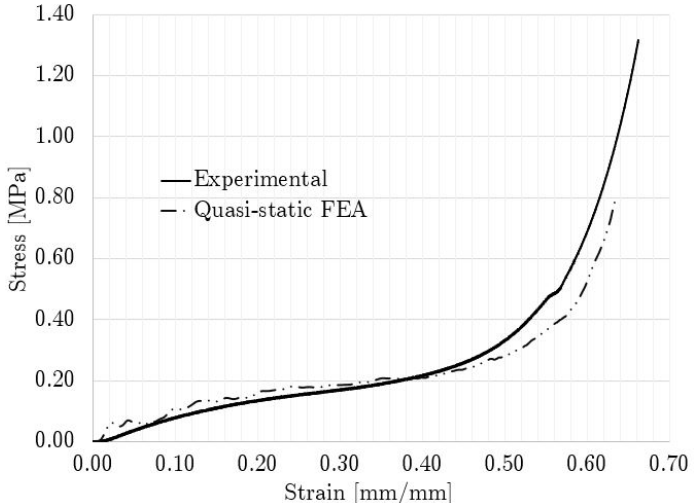
Figure 7. Quasi ‐ static stress–strain curve comparison for non ‐ graded lattice. Figure 7. Quasi-static stress–strain curve comparison for non-graded